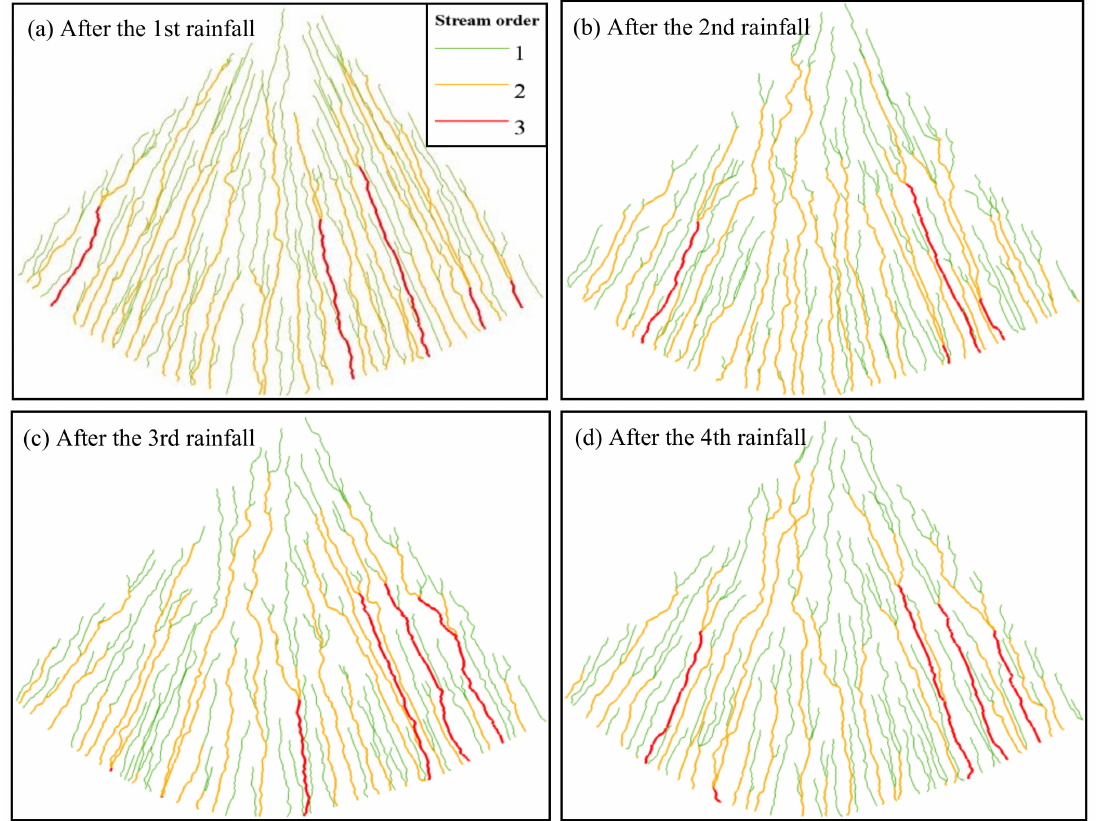
Figure 6. Drainage networks evolution for the 90 mm/h rainfall intensity treatment (the stream order was classified by STRAHLER method), ( a – d ) respectively shows the drainage network after the first to fourth